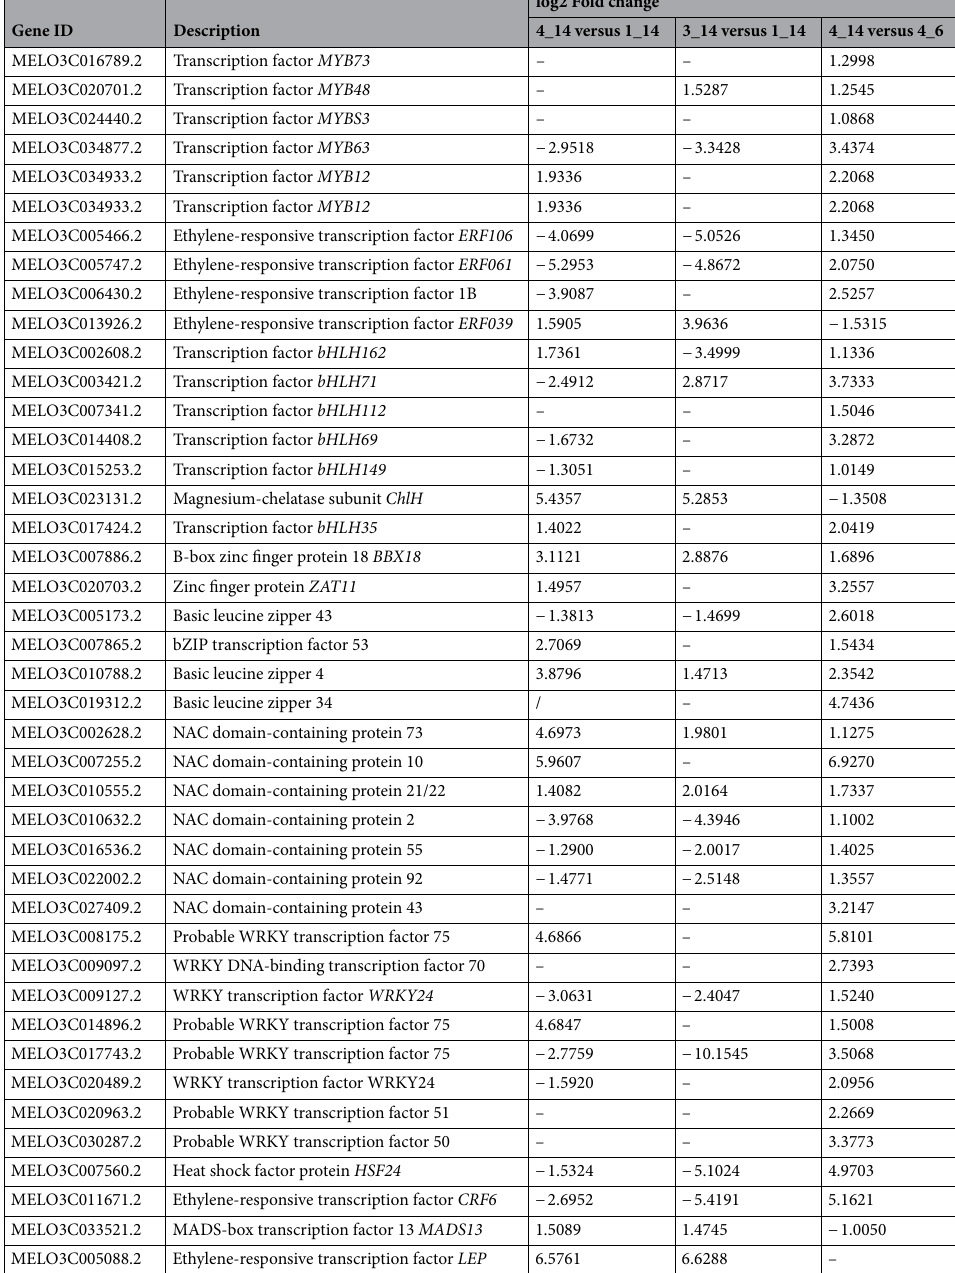
Table 1. Differential expression analysis of transcription